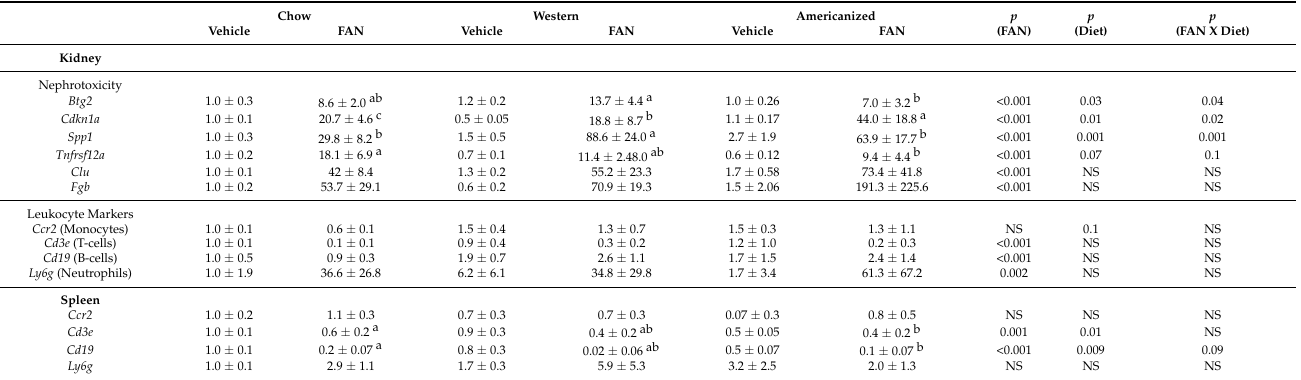
Data are presented normalized to average of the Vehicle treated chow-fed group for each gene. Different superscript letters (a vs. b) signify significant difference between diets ( p < 0.05) as determined by Two-Way ANOVA with Tukey Post Hoc test. Treatments with similar superscript letters are not statistically different ( p > 0.05). Data analyzed with 2-Way ANOVA and Tukey post hoc analysis. ND-not detected, NS- p >